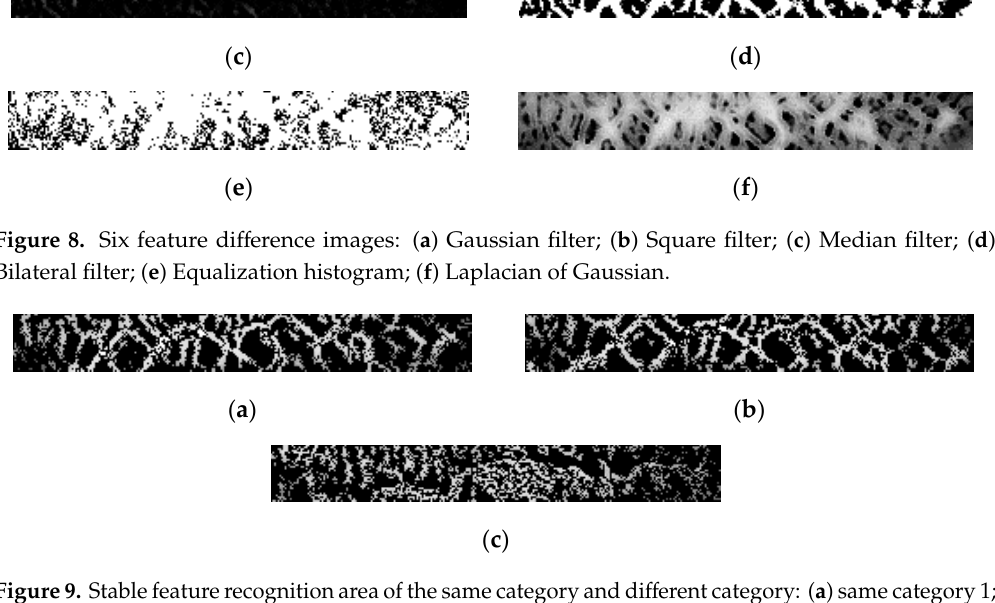
Figure 9. Stable feature recognition area of the same category and di ff erent category: ( a ) same category 1; ( b ) same category 2; ( c ) di ff erent category.